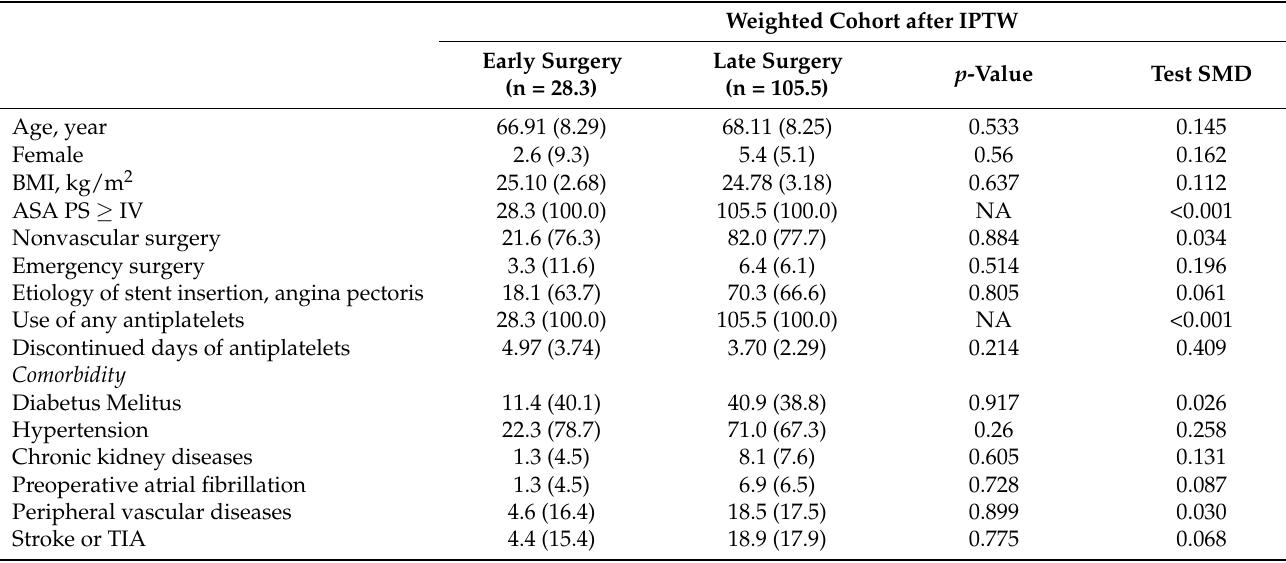
Table A1. Baseline Patient and Operative Characteristics after